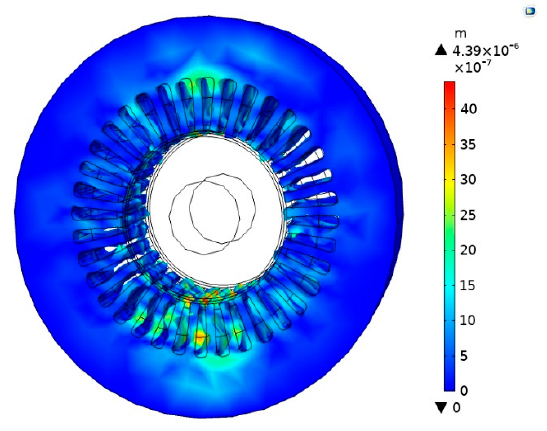
Figure 5. Deformation of the stator due to magnetic forces from the solid-mechanics FEM. Displacement scale factor: 5000.